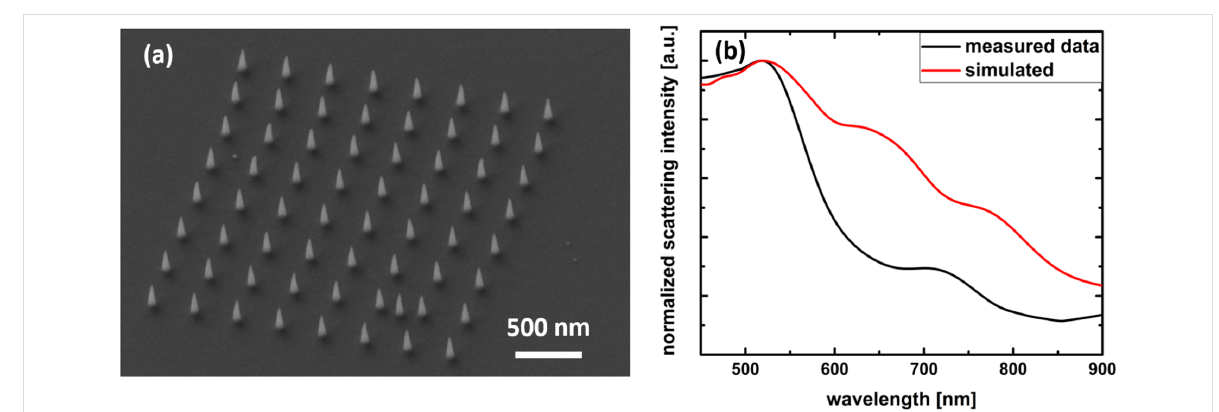
Figure 5: (a) Array of 8 × 8 nanocones with a distance of 400 nm, base diameter of 80 nm and a height of 250 nm. (b) Measured and simulated scat- tering spectra of the